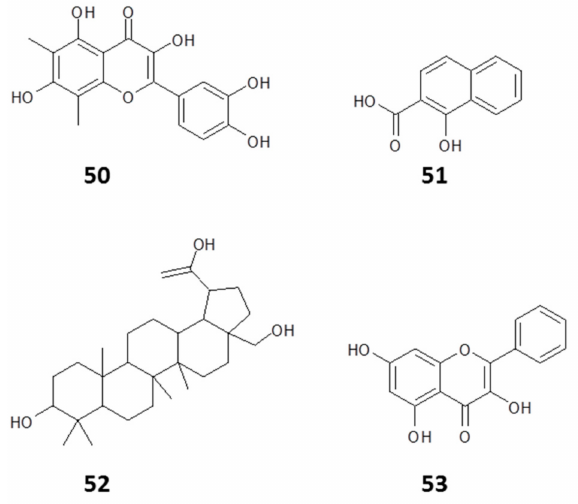
Figure 9. Compounds identified in the ethanolic extracts of Libyan propolis samples with anticrithidial activity